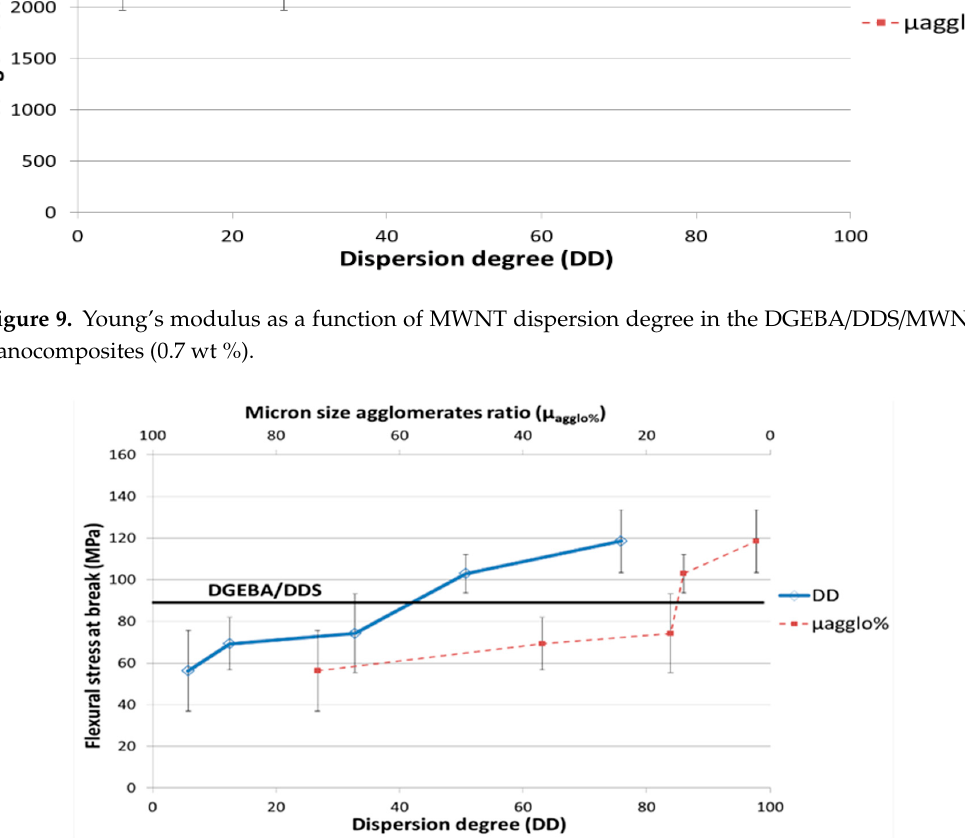
Figure 10. Flexural stress at break as a function of MWNT dispersion degree in the DGEBA/DDS/MWNT nanocomposites (0.7 wt